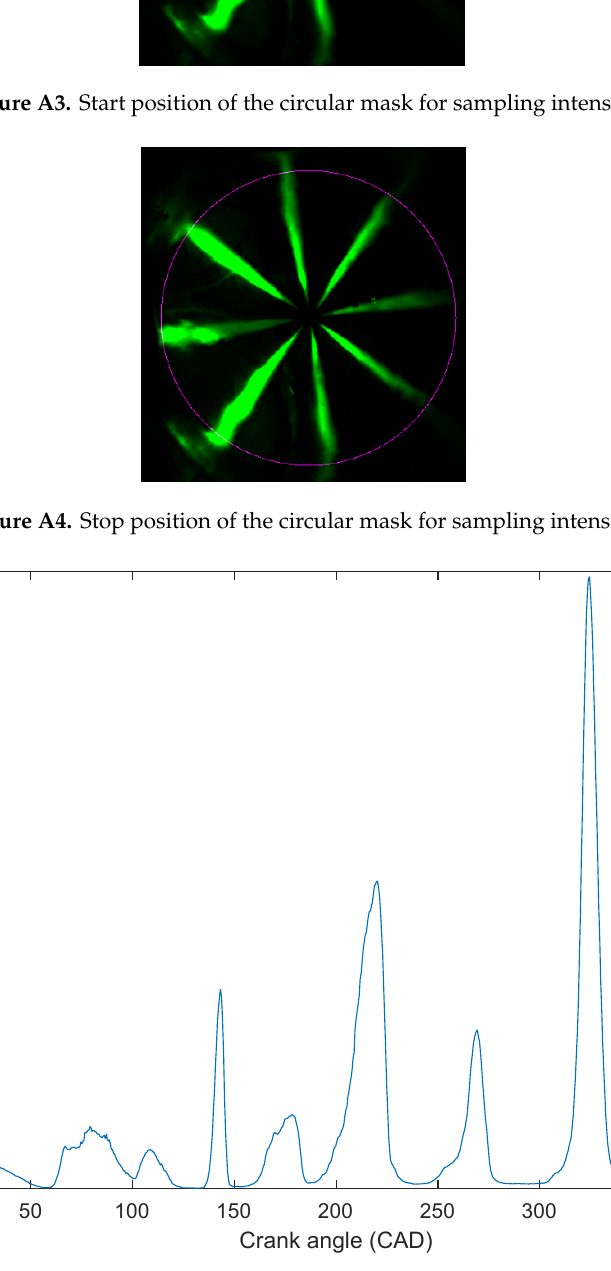
Figure A5. Averaged intensity single from the sampling of a series of circular masks, to find the strongest scattering spray and its angular position.